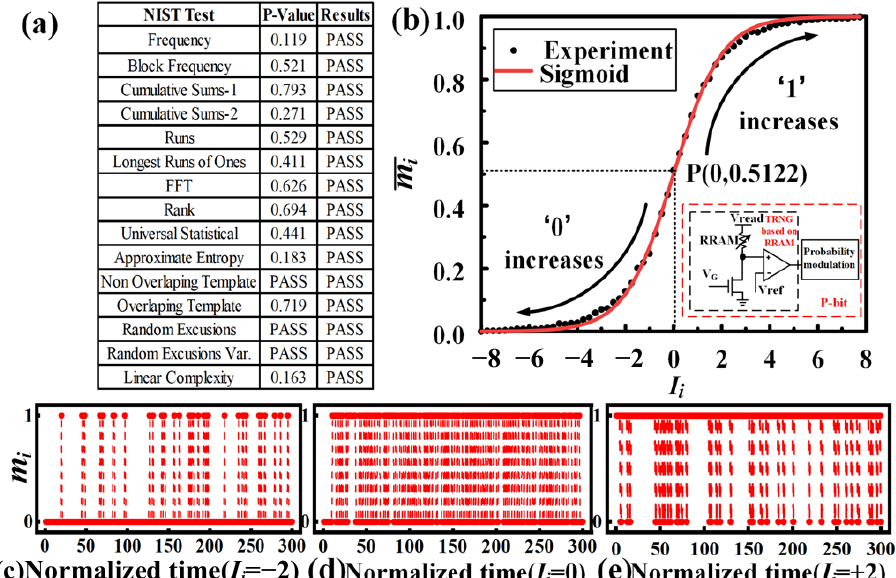
Figure 3. Probabilistic-adjustable randomness of P-bit. ( a ) NIST-verified results at p = 0.5; ( b ) the time-averaged output of p-bit, which fits sigmoid well; ( c – e ) the statistical value of m i when I i is equal to − 2, 0, +2, respectively, over 300 cycles.